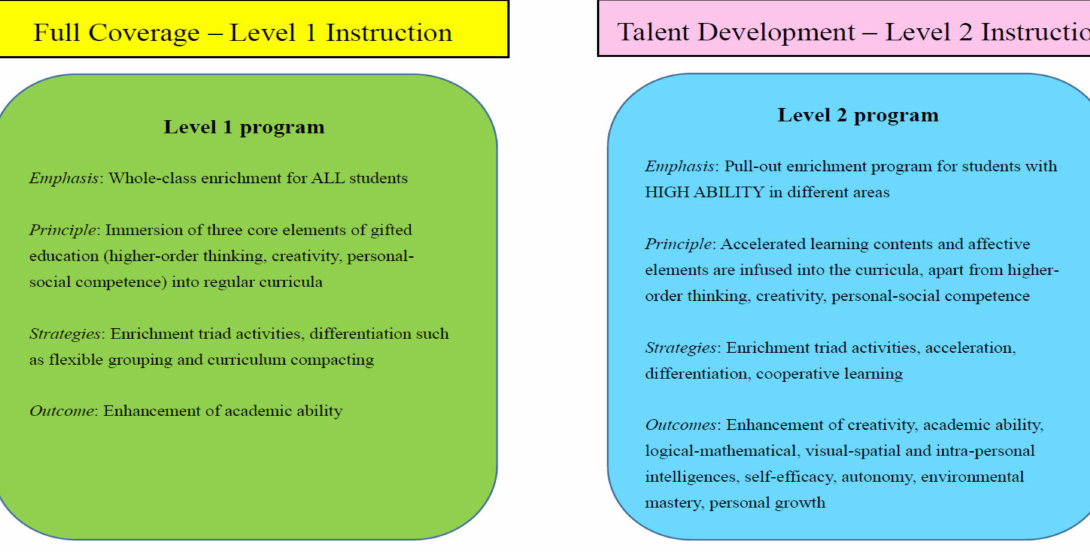
Figure 2. Level 1 and Level 2